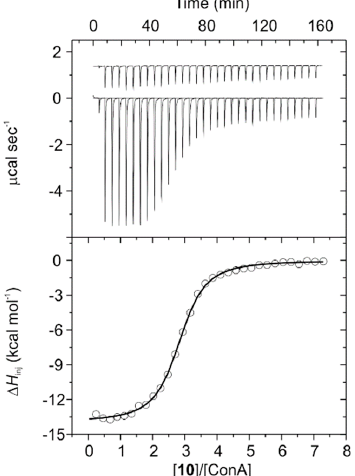
Figure 4. Titration of concanavalin A (ConA) with conjugate 10 in 20 mM phosphate buffer (pH 7.2) at 25 °C. The top panel shows the raw calorimetric data denoting the amount of generated (negative exothermic peaks) heat following each injection of the conjugate. The area under each peak represents the amount of heat released upon binding of the conjugate to the lectin. Note that as the titration progresses, the area under the peaks gradually becomes smaller because of the increasing saturation of the sugar binding sites of the protein. This area was integrated and plotted against the molar ratio of the conjugate to ConA (as tetramer). The smooth solid line represents the best fit of the experimental data to the model of n equal and independent binding sites. Table 1. Thermodynamics and stability constants for the binding of conjugates 8 , 10 , nanoMOFs@ 8, and nanoMOFs@ 10 to ConA according to an n equal and independent binding sites model.